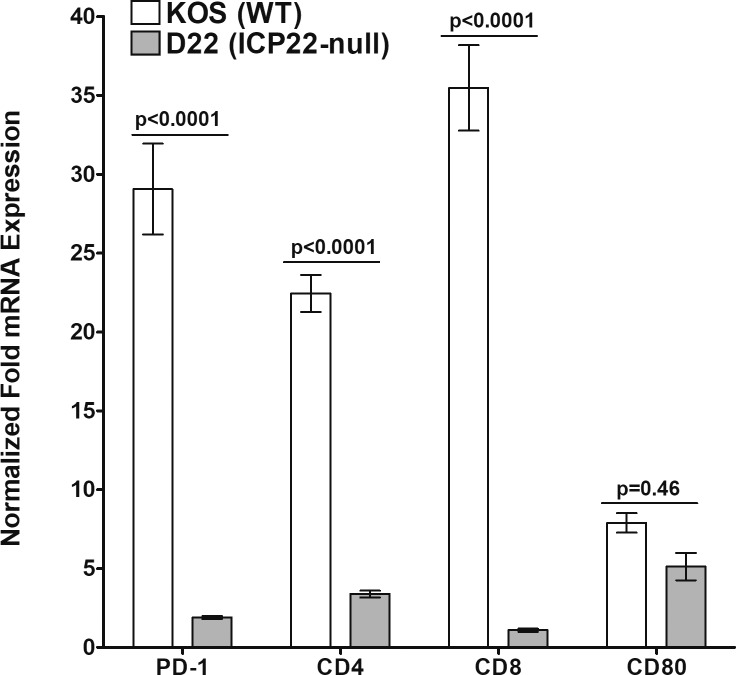
Quantitation of PD-1, CD4, CD8, and CD80 RNA transcripts in TG of latently infected BALB/c mice with avirulent parental KOS and ICP22 null HSV-1 virus. TG were collected from mice infected with KOS or ICP22 null HSV-1. Virus was harvested from TG on day 28 PI (after latency). Total RNA isolated from each TG was used to estimate the relative expression of each transcript in the TG of BALB/c mice. GAPDH expression was used to normalize the expression of each transcript in the TG of ocularly infected mice. For parental KOS, each bar represents the mean ± SEM from 12 TG, while for ICP22 null–infected mice, each bar represents the mean ± SEM from 13 TG.